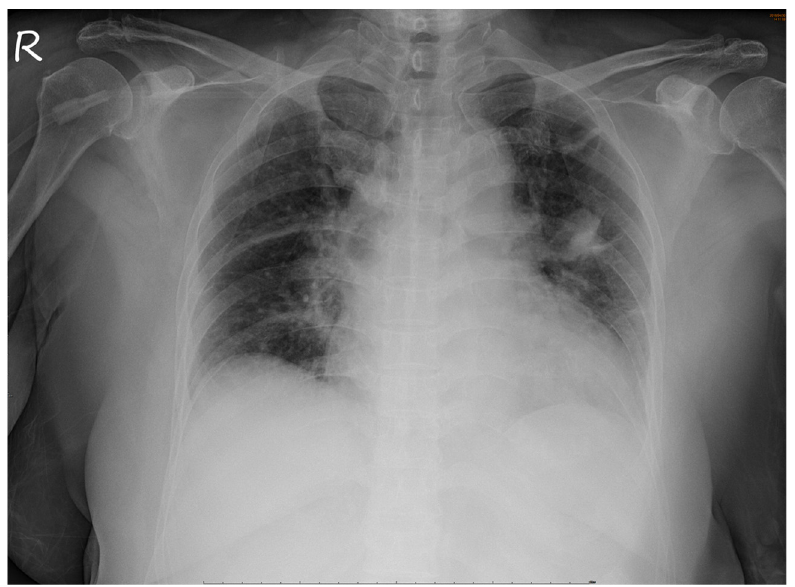
Figure 4. Chest radiograph. A non-homogenous patch is seen in the superior lobe of the left lung. Since the patient had a family history of lung cancer, whole-body positron emission tomography/computed tomography (PET/CT) was suggested; the results showed focal up- take in the left eye with a standardized uptake value (SUV) of 10.8, left upper lung (SUV: 11.5), mediastinum (SUV: 14.8), liver (SUV: 9.6), and bone (SUV: 10) (Figures 5 and 6).